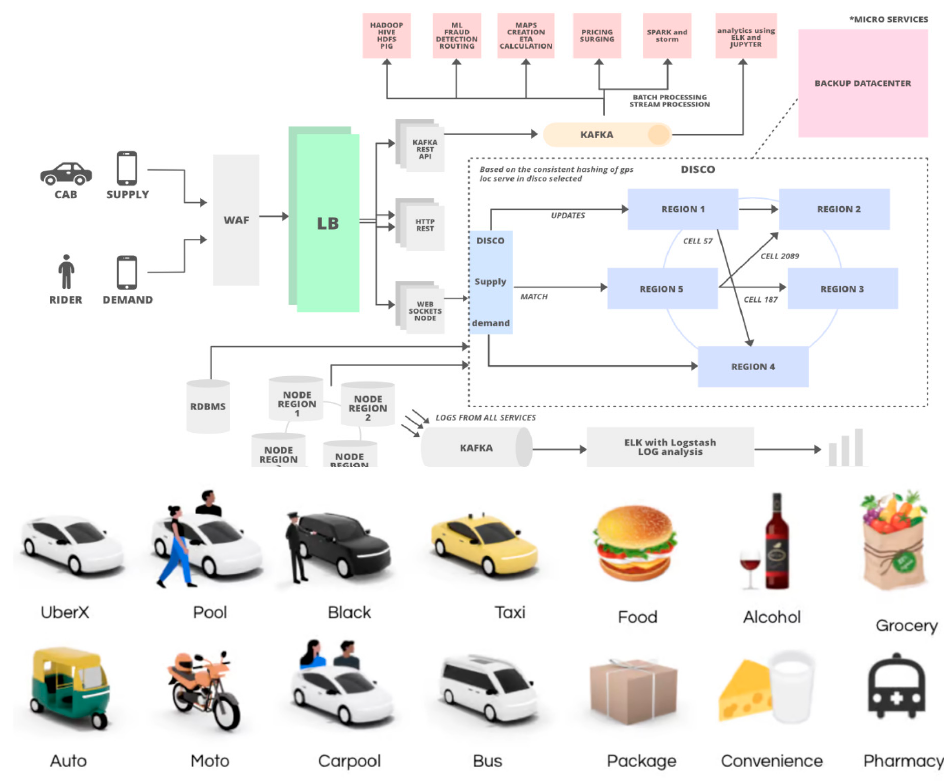
Figure 3. Uber business model and their business expansion.